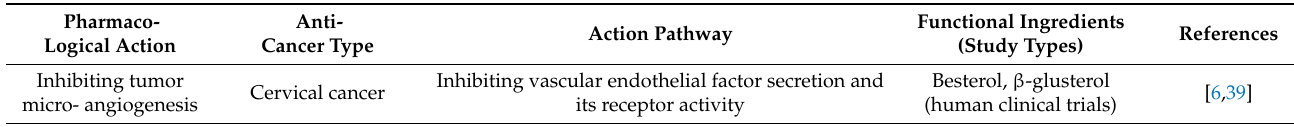
Table 3. Action pathway and functional ingredients of adlay in the treatment 13 cancer